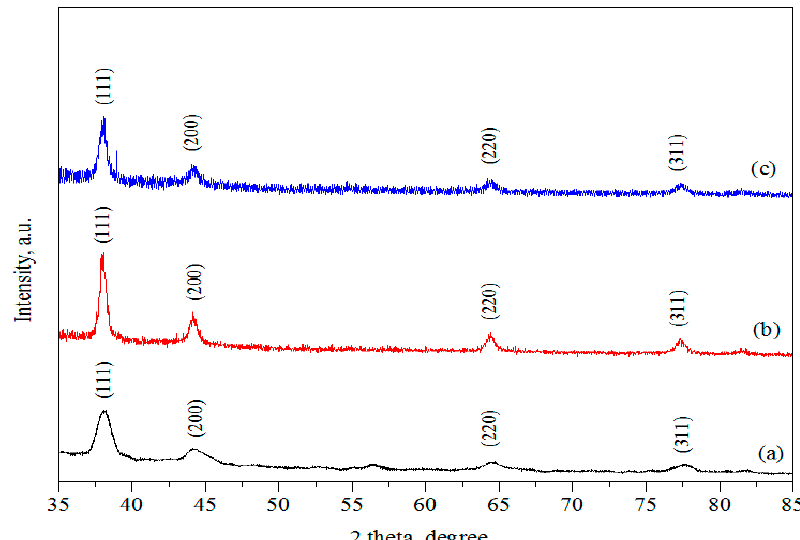
Figure 4. XRD patterns of the ( a ) Au NPs, and Au ‐ Ag bimetallic NPs at ( b ) 2.0 mL and ( c ) 5.0 mL Au seed volumes of Au seed.